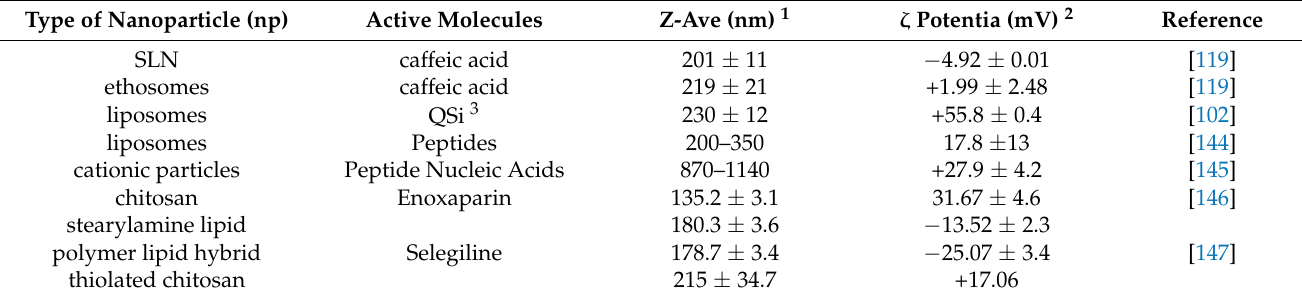
Table 5. Z-average and zeta potential values of some nanoparticles reported in literature. Type of Nanoparticle